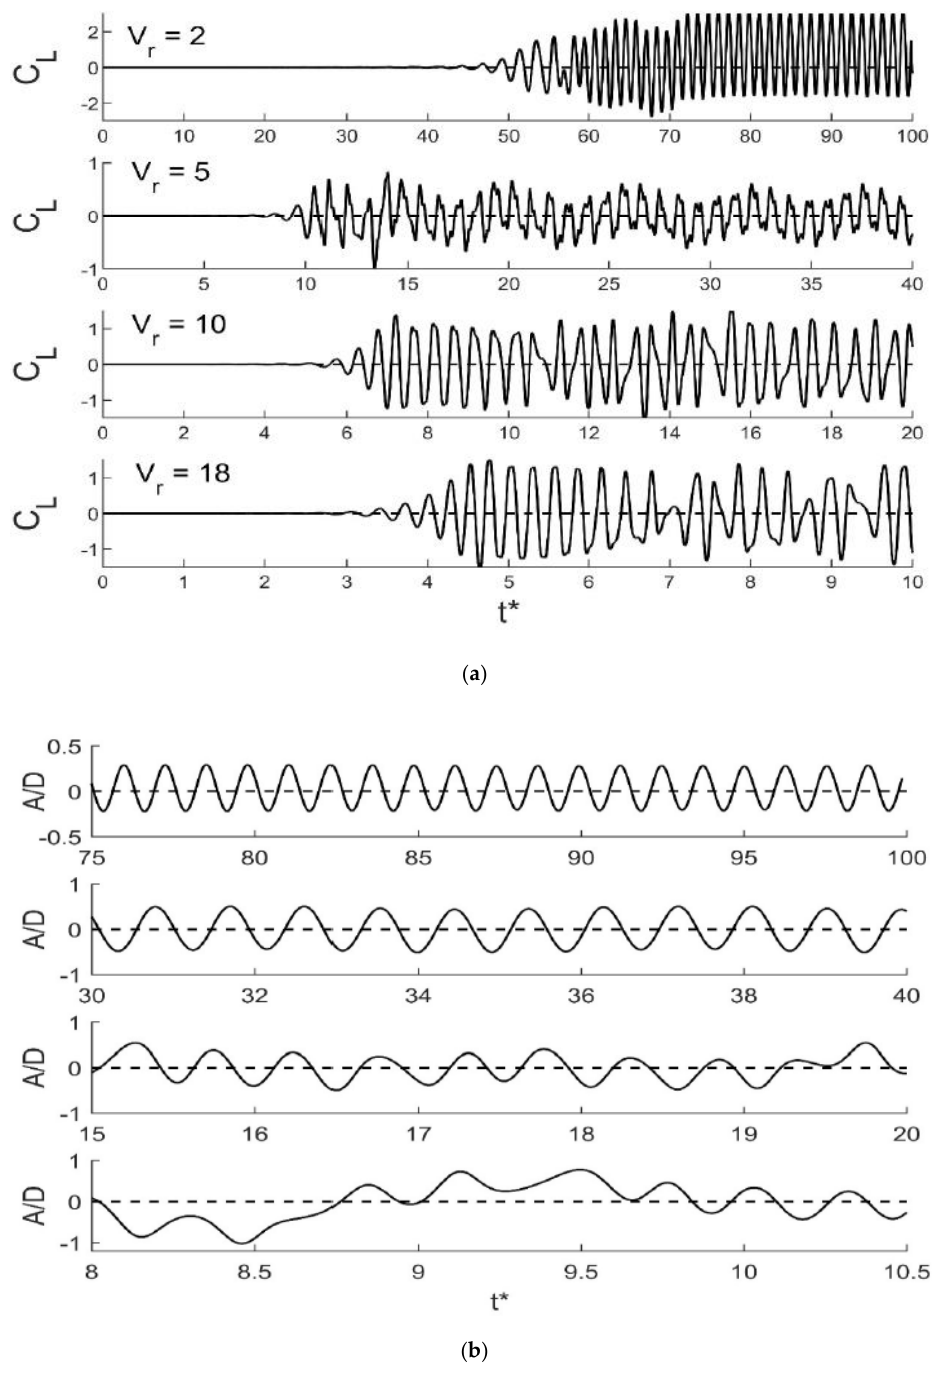
Figure 5. Time histories of the ( a ) lift coe ffi cient and ( b ) normalized amplitudes of the face-oriented hexagonal at V r = 2, V r = 5, V r = 10, and V r =